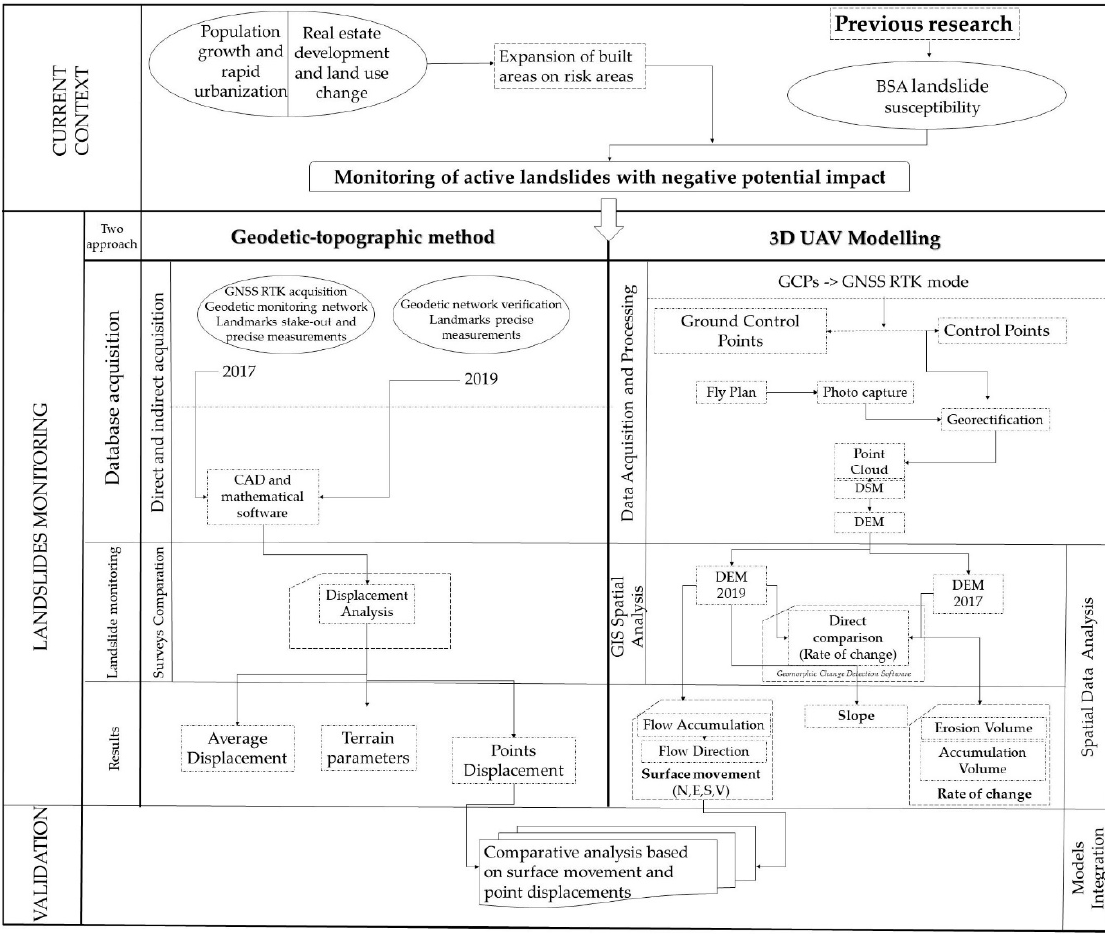
Figure 3. Methodological flowchart.